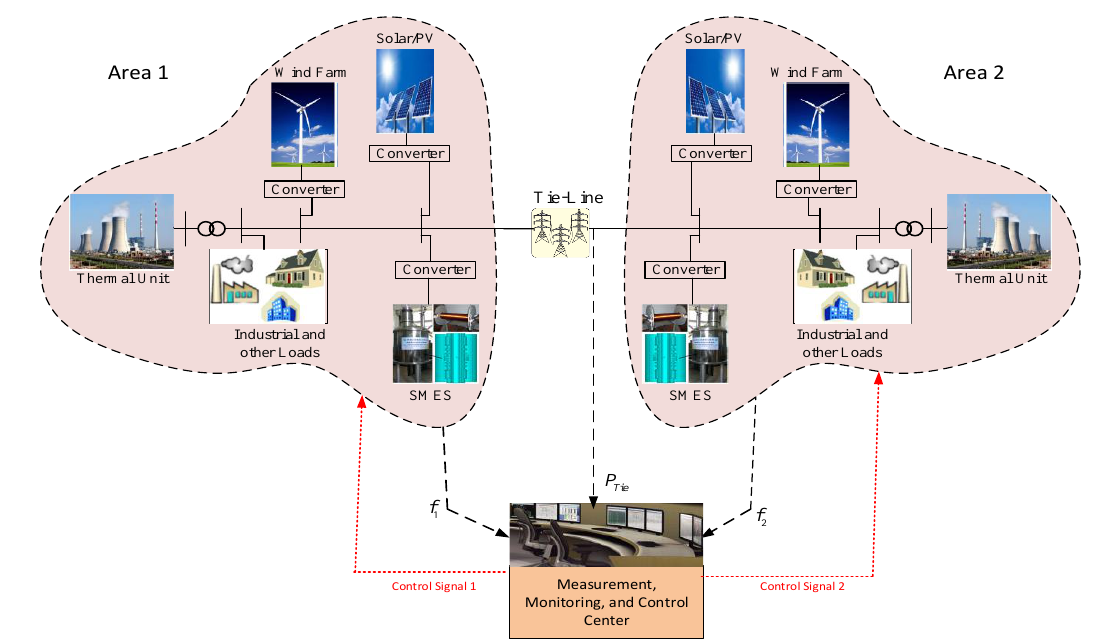
Figure 1. Renewable energy integrated two area power system.